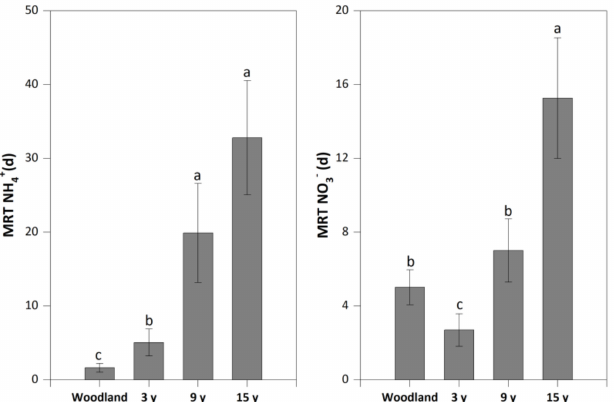
Figure 3. The mean residence time of NH 4+ (MRT NH 4+ ) and NO 3 − (MRT NO 3 − ) in soils under woodland and three pitaya plantations. Error bars depict standard deviations. Identical letters for MRT NH 4+ and MRT NO 3 − indicate no significant differences between woodland and the three pitaya plantations at p > 0.05.